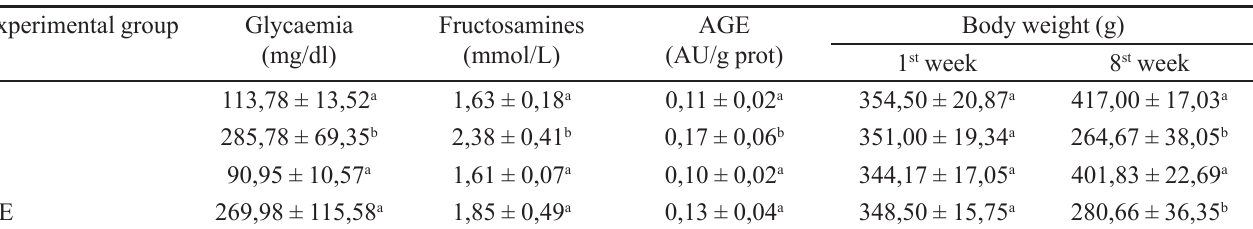
The results represent the average ± standard deviation of 6-8 determinations per treatment. Different letters in the same column indicate statistical significance, p<0.05. C=control group; D=diabetic animals; E= P. edulis ethanolic extract-treated non-diabetic animals; DE= P. edulis ethanolic extract-treated diabetic